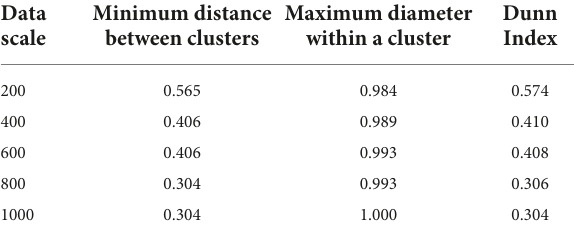
TABLE 3 Evaluation results of algorithms based on cosine similarity.